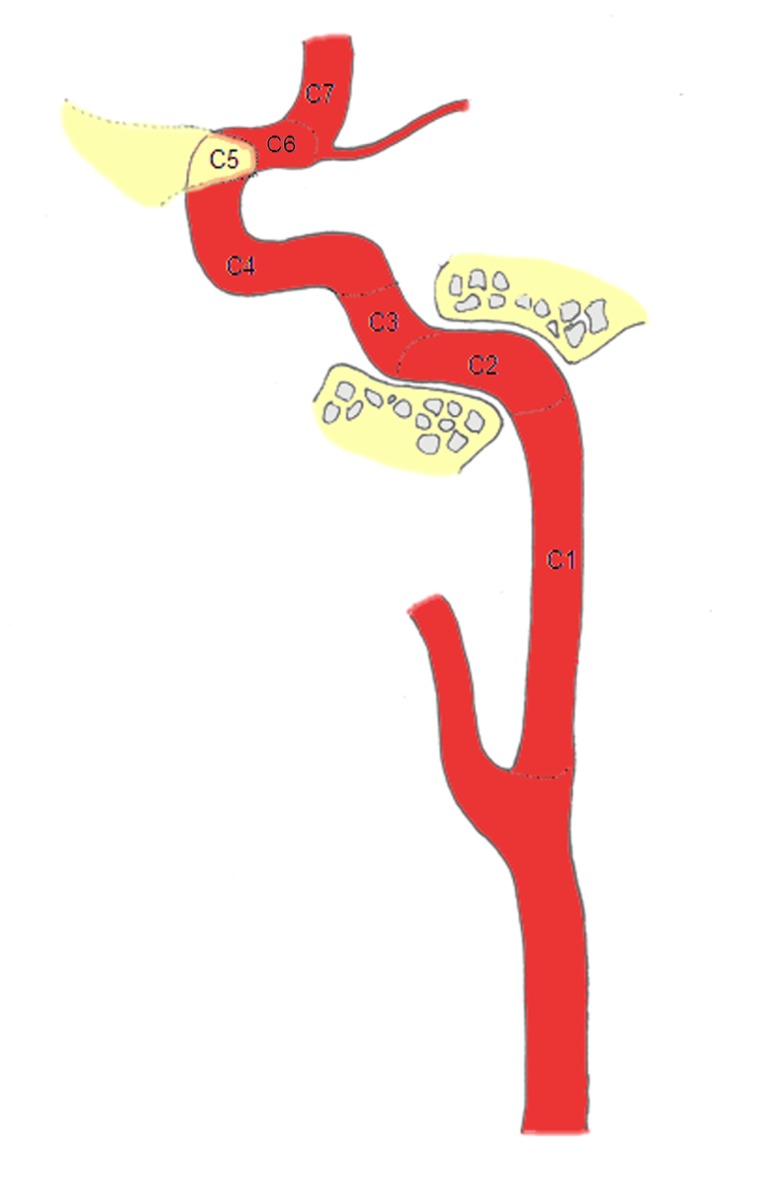
Schematic diagram illustrating the segments of the internal carotid artery (ICA).C1 (cervical segment) begins at the level of the common carotid artery bifurcation to the entrance level of the carotid canal. C2 (petrous segment) extends within the carotid canal. C3 (lacerum segment) begins where the carotid canal ends and ends at the superior margin of the petrolingual ligament. C4 (cavernous segment) is surrounded by the cavernous sinus. C5 (clinoid segment) begins at the proximal dural ring and ends at the distal dural ring where the ICA extends through the medial side of anterior clinoid process. C6 (ophthalmic segment) begins at the distal dural ring and ends just proximal to the origin of the posterior communicating artery (PComA). C7 (communicating segment) begins just proximal to the origin of the PComA and ends at the ICA bifurcation.